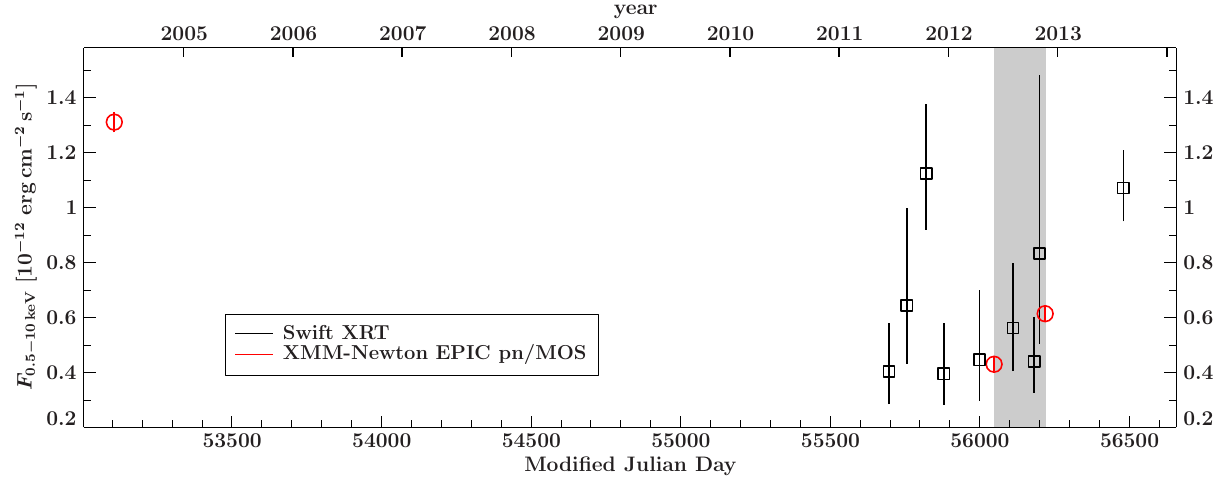
Figure 1. Unabsorbed 0 . 5 − 10keV flux of PKS2004 − 447 as a function of time. Red dots refer to XMM-Newton observations, while black suqares resemble Swift XRT observations. The grey-shaded background marks the period of our multiwave- length campaign.